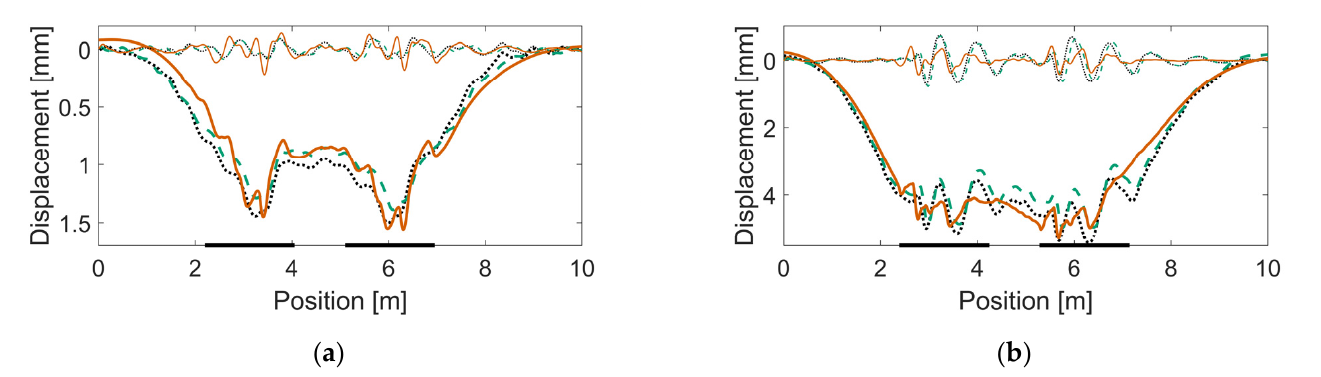
also the caption of Figure 17. (facing move: three voided sleepers). See